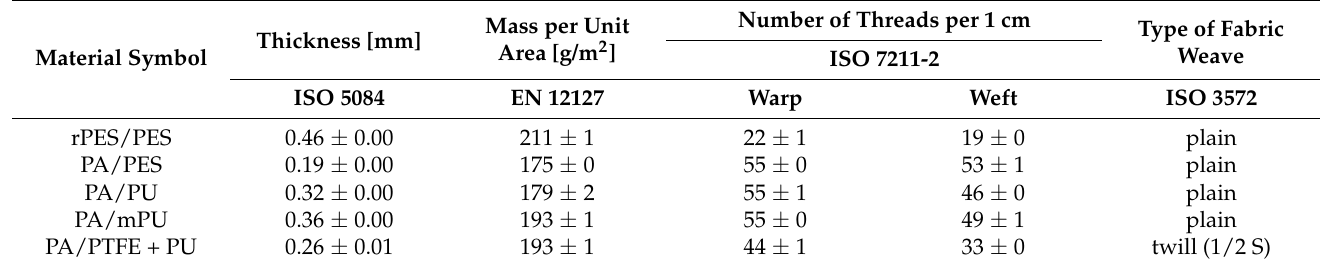
Table 2. Structural parameters of laminated textile materials used in the